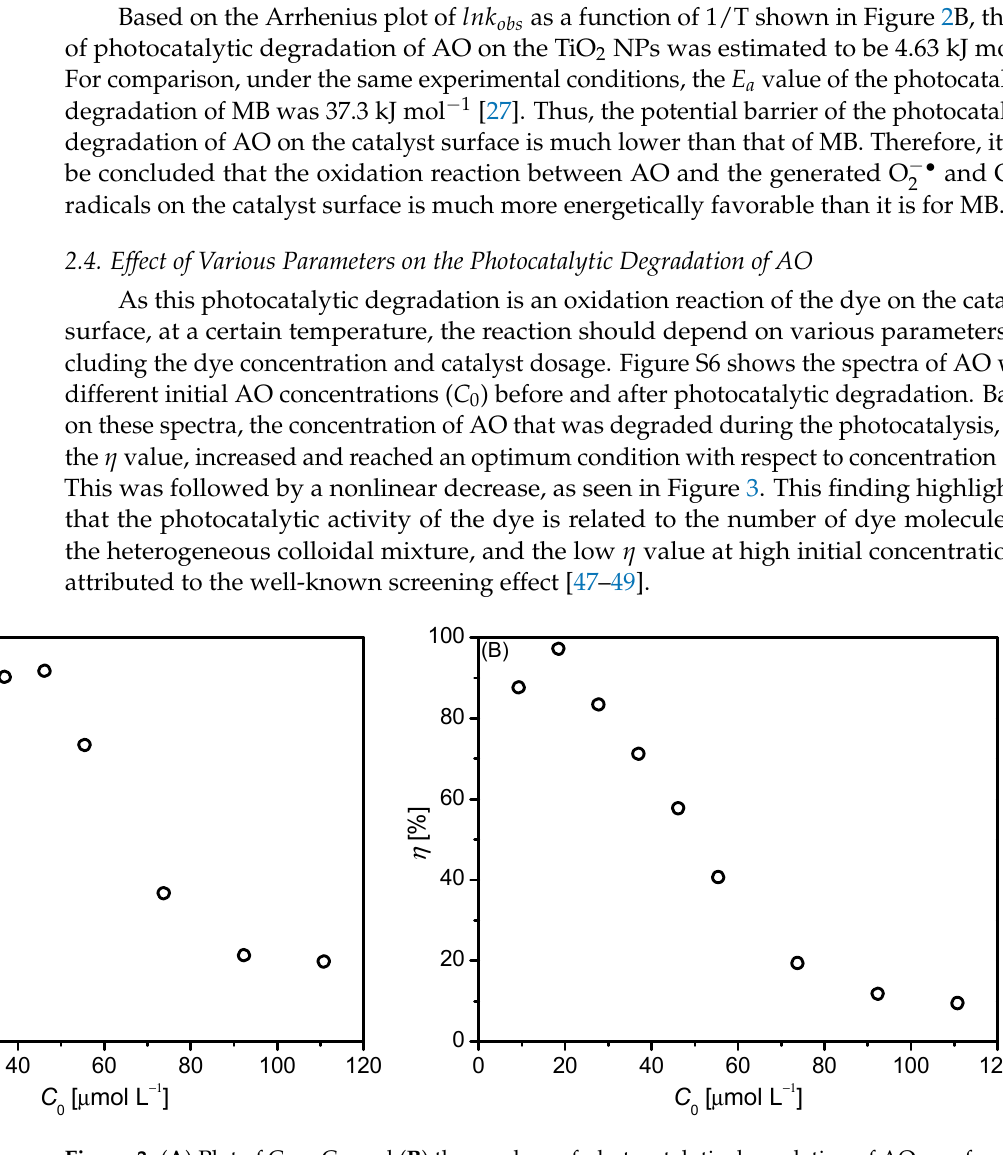
− C Figure 3. ( A ) Plot of C ; and ( B ) the 𝜂 values of photocatalytic degradation of AO as a function Figure 3. ( A ) Plot of C 0 − C t ; and ( B ) the η values of photocatalytic degradation of AO as a function (cid:2868) (cid:2930) of the initial AO concentration ( C 0 ) in the colloidal mixture with 5 mg TiO 2 NPs after irradiation for ) in the colloidal mixture with 5 mg TiO 2 NPs after irradiation for of the initial AO concentration ( 𝐶 (cid:2868) 30 30 min.